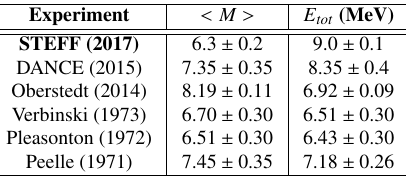
Table 1: Comparison of average mul- tiplicity and total energy with pre- vious experimental data. In STEFF (2017) the energy range of neutrons